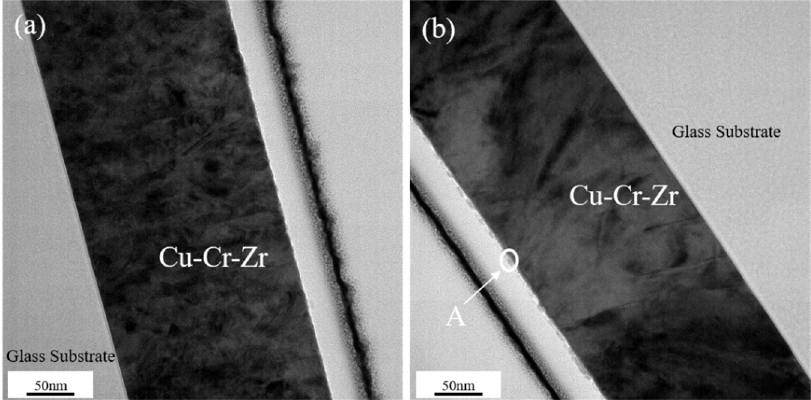
Figure 5. Focused Ion Beam (FIB)-TEM micrographs of the alloy thin films: ( a ) Cu-Cr-Zr film before annealing; ( b ) Cu-Cr-Zr film after annealing at 300 °C.